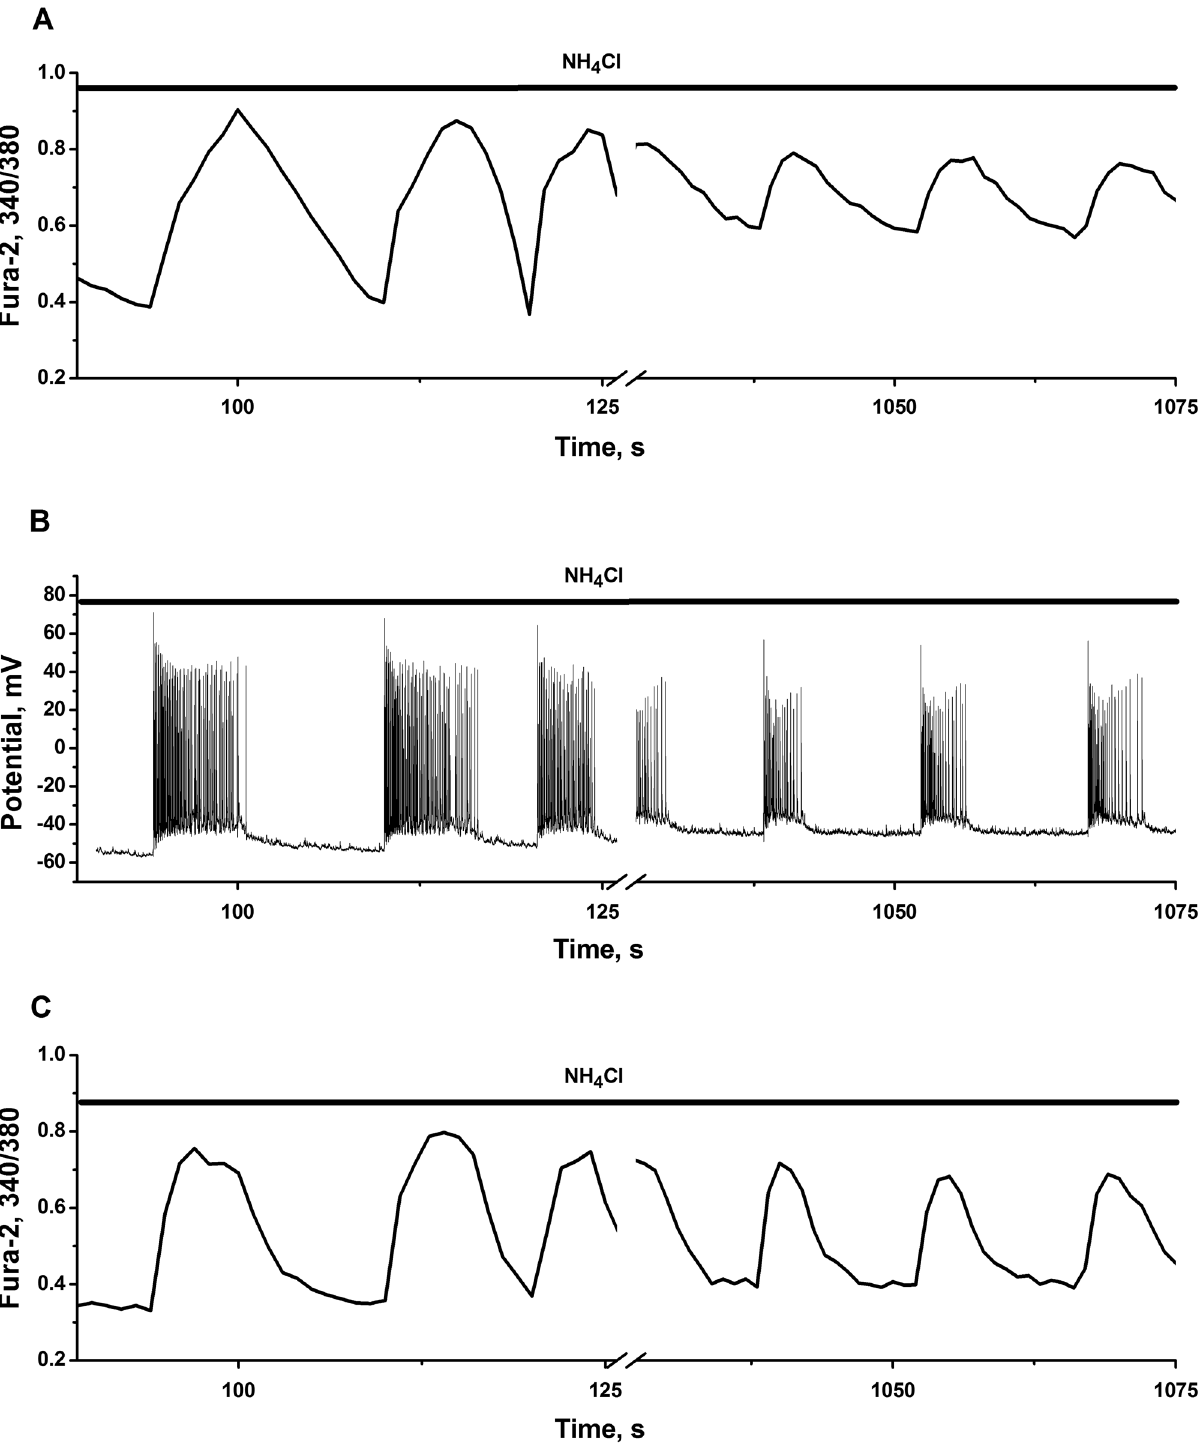
Fig 6. Simultaneous recordings of membrane potential and of Ca 2+ -oscillations in «run out» cell and representative cell in network activated by 5 mM NH 4 Cl. Neuronal culture 16 DIV. Total number of neuronal cells involved into network is 106. Gaps in the traces represent pauses in data recordings. Here are presented only parts of 3 records. Initial parts were omitted for simplicity. (A) Recording of Ca 2+ -oscillations in «run out» cell. (B) Recording of membrane potential in «run out» cell. (C) Recording of Ca 2+ -oscillations in representative cell (one of 95% cells monitored in network).